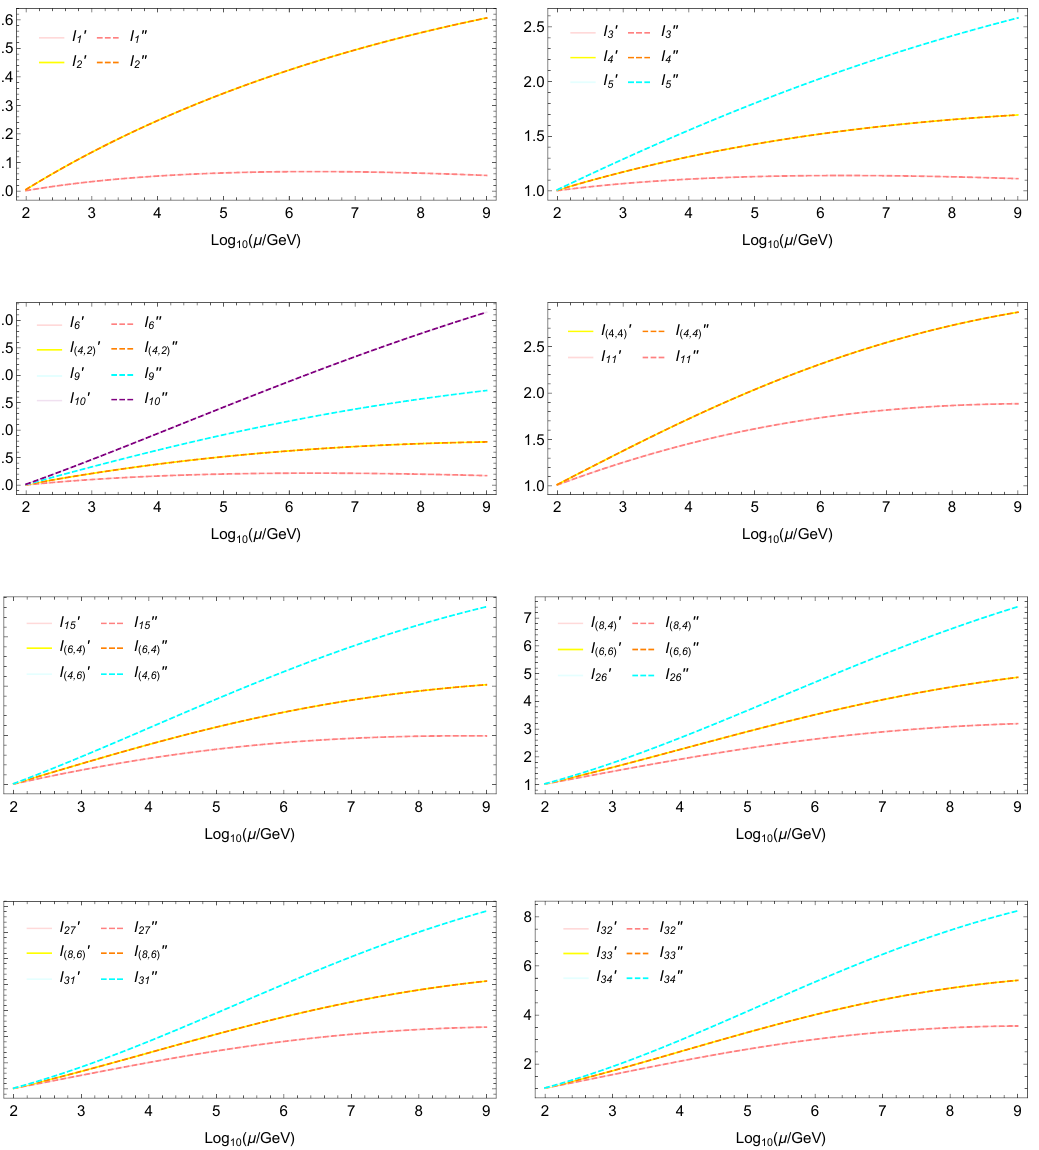
Figure 1 . The evolution of the 34 basic flavor invariants in the generating set from µ = 10 2 GeV to µ = 10 9 GeV . Note that all the curves in the figure correspond to the invariants normalized by their initial values, i.e., I 0 ( 00 )